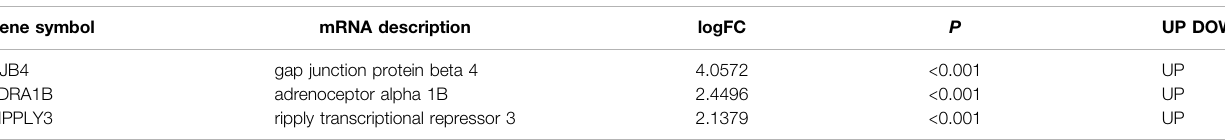
TABLE 3 | Differential expression information of characteristic genes.